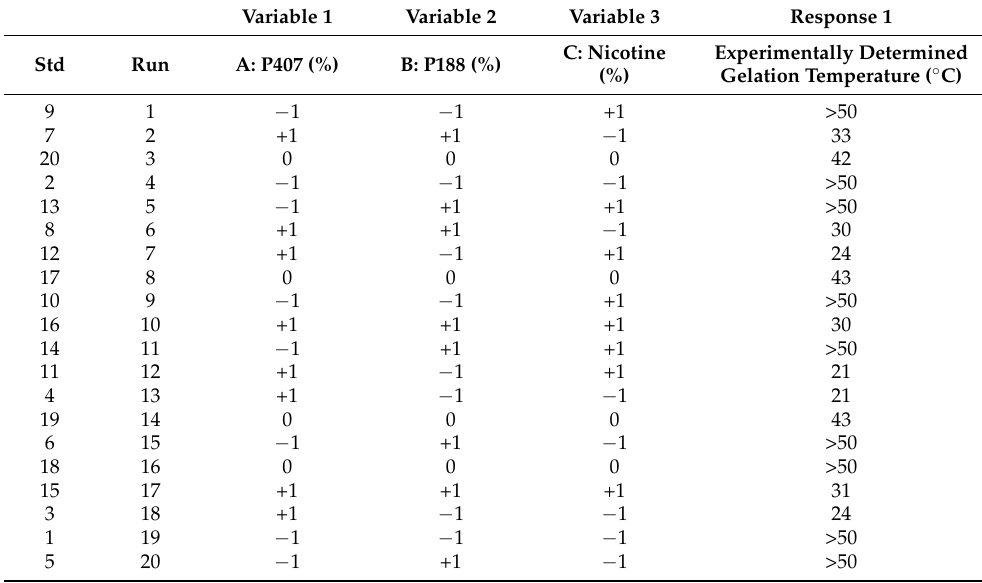
Table 1. First screening design showing variables (in coded values) and responses.